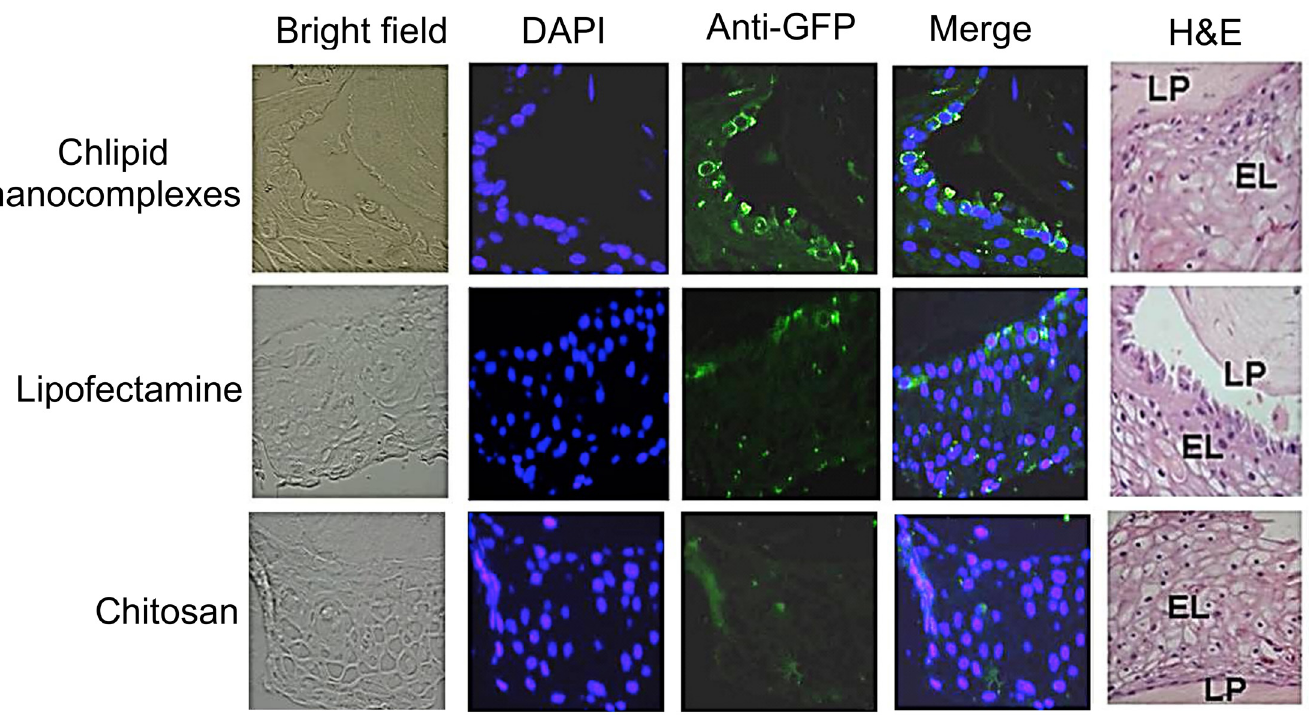
Fig 3. Transfection of cells in a 3D-VEC model. Cells in the 3D-VEC model were transfected with either chitosan or Lipofectamine 2000 or CNs complexed with pEGFP. At 48 h post-transfection, the tissues were fixed in 10% formalin, paraffin-embedded, and immunostained using anti-GFP antibody and nuclear- stained with DAPI. H&E stained histological (formalin-fixed) cross-sections of VLC-FT are also shown. LP, lamina propria; EL, epithelial layers.